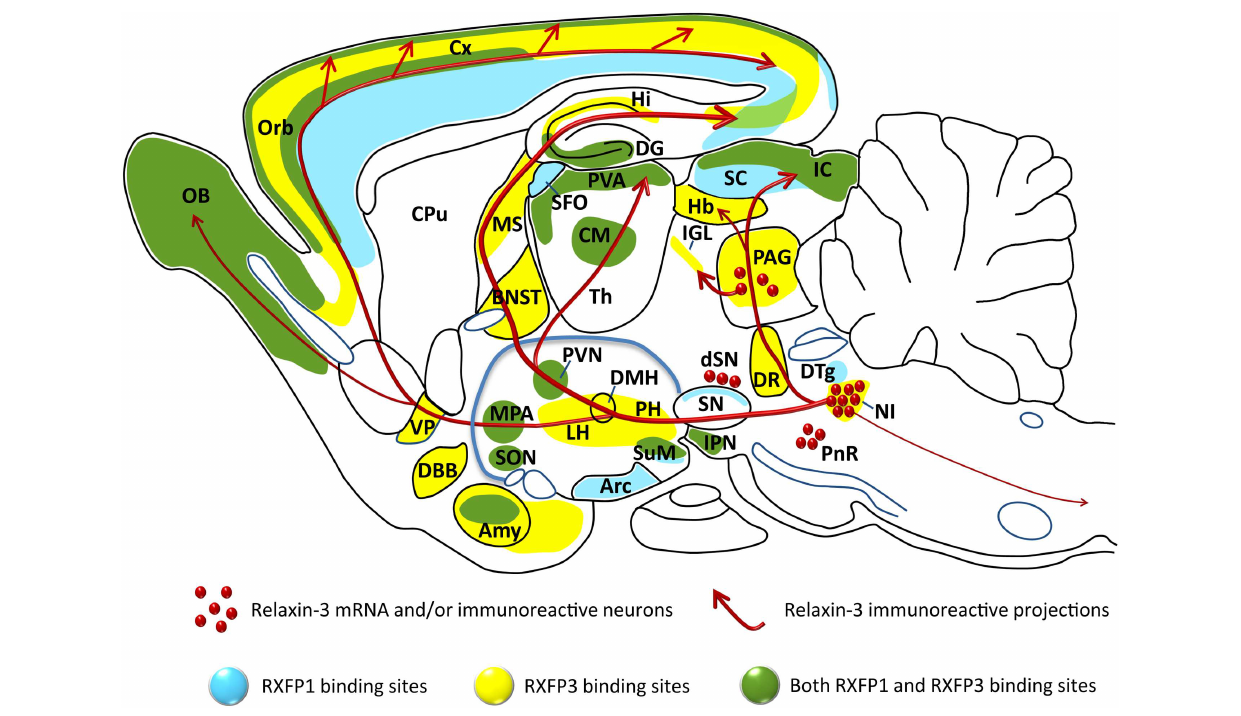
colliculus; IGL, intergeniculate leaflet; IPN, interpeduncular nucleus; LH, lateral hypothalamus; MPA, medial preoptic area; MS, medial septum; NI, nucleus incertus; OB, olfactory bulb; Orb, orbitofrontal cortex; PAG, periaqueductal gray; PH, posterior hypothalamus; PnR, pontine raphe; PVA, paraventricular thalamic area; PVN, paraventricular nucleus of hypothalamus; SC, superior colliculus; SFO, subfornical organ; SON, supraoptic nucleus; SN, substantia nigra; SuM, supramammillary nucleus;Th, thalamus;VP, ventral pallidum. Adapted from a figure kindly provided by Dr. Craig Smith (The Florey Institute of Neuroscience and Mental Health, Melbourne,